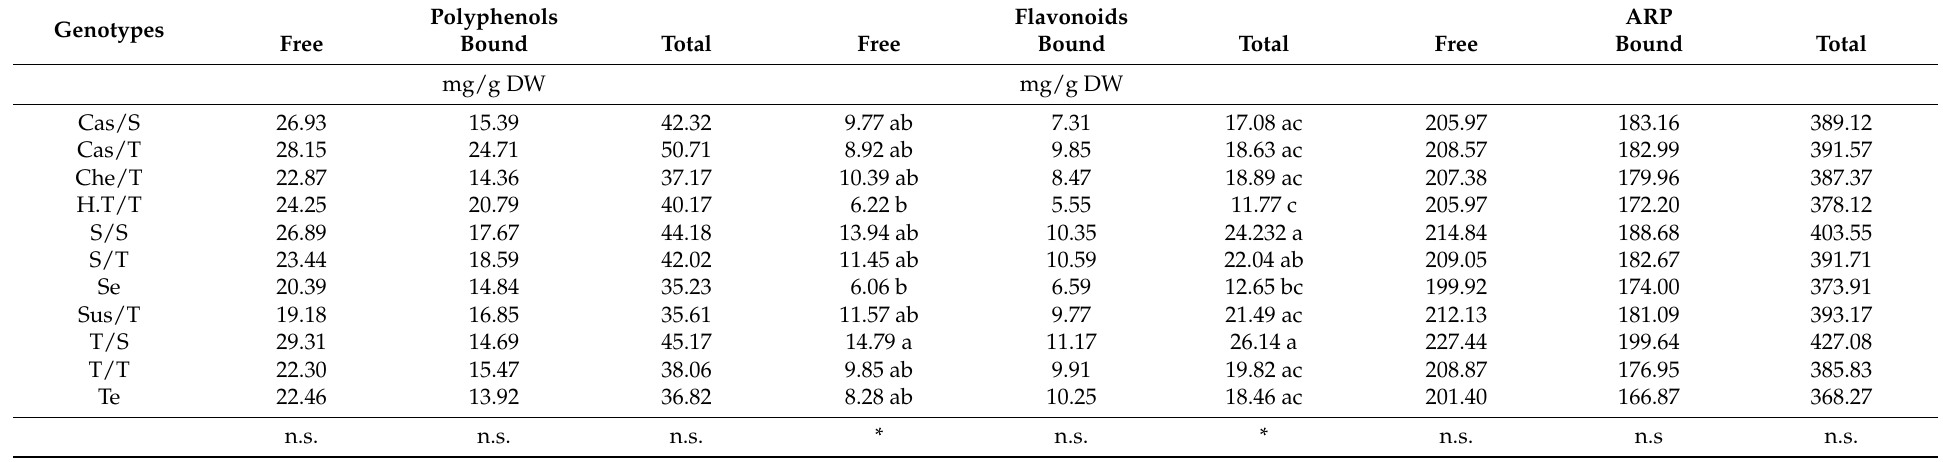
Table 1. Polyphenol and flavonoid contents, and antiradical power (ARP) of all hop samples (cones) considered in this study.